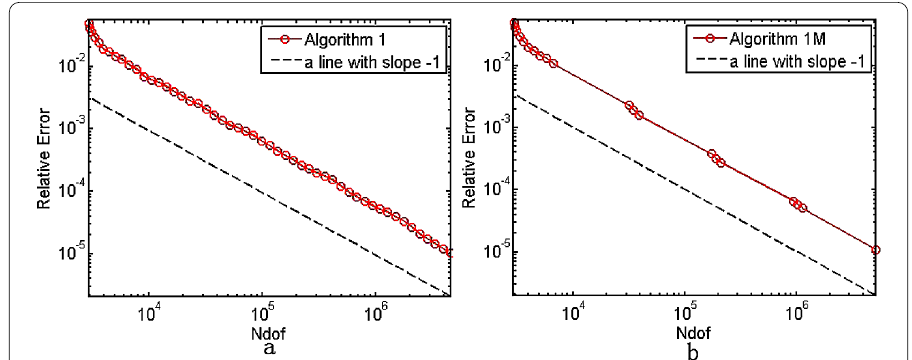
Figure 1 The convergence rates of the smallest eigenvalue from Algorithm 1(a) and Algorithm 1M(b)